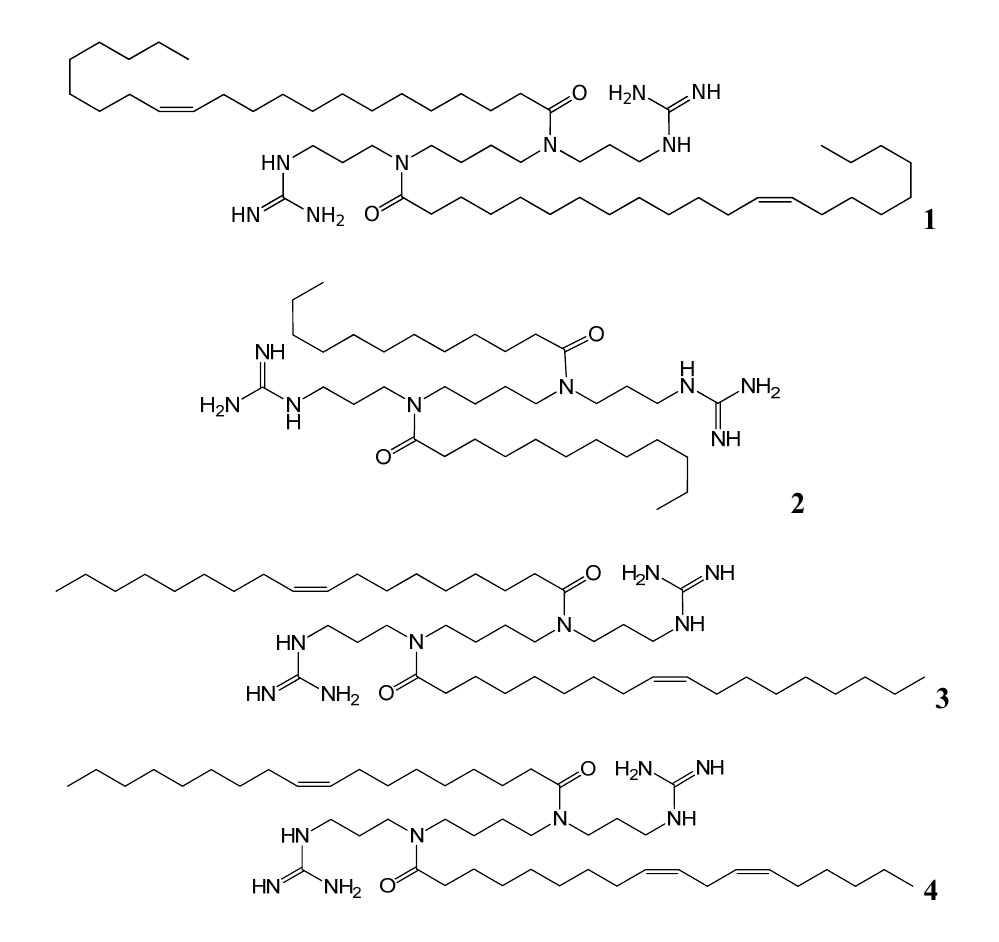
Figure 3. N 1 , N 12 -Diamidine derivatives of different